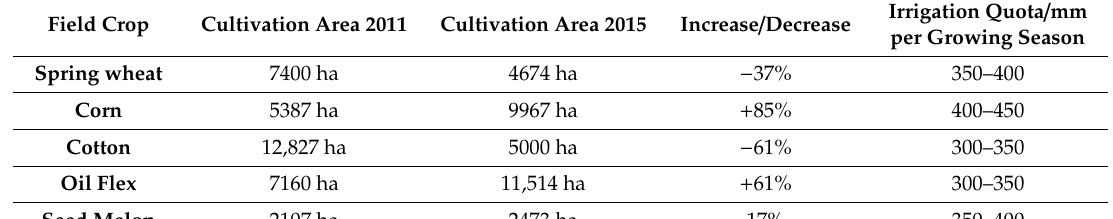
Table 1. Quantitative distribution of field crops in Minquin and irrigation requirements (based on [14]).